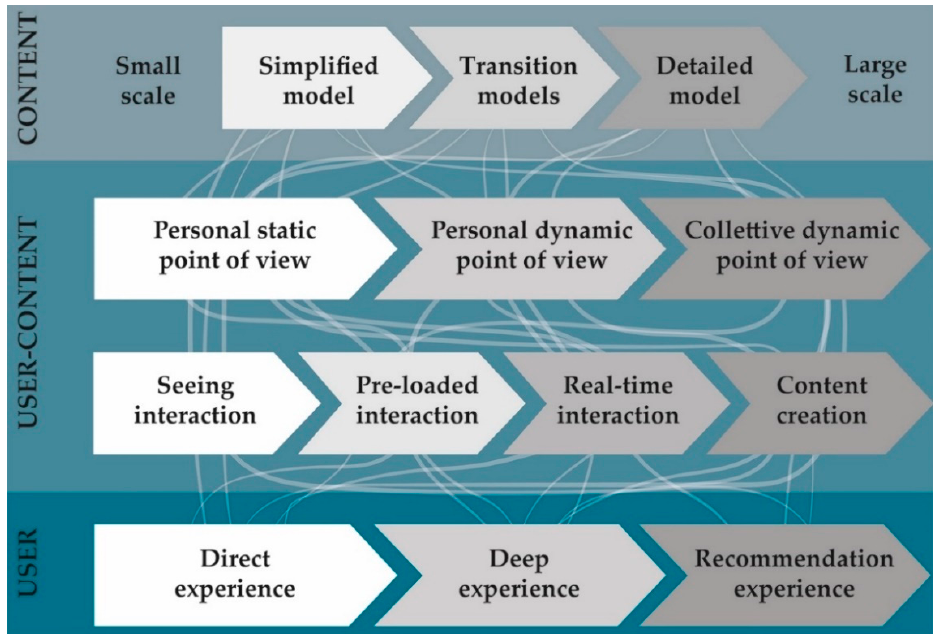
Figure 15. Block diagram showing the relationships between some critical aspects related to the AR user experience. The graphical network behind the pipelines outlines some possible interactions between all of the elements.